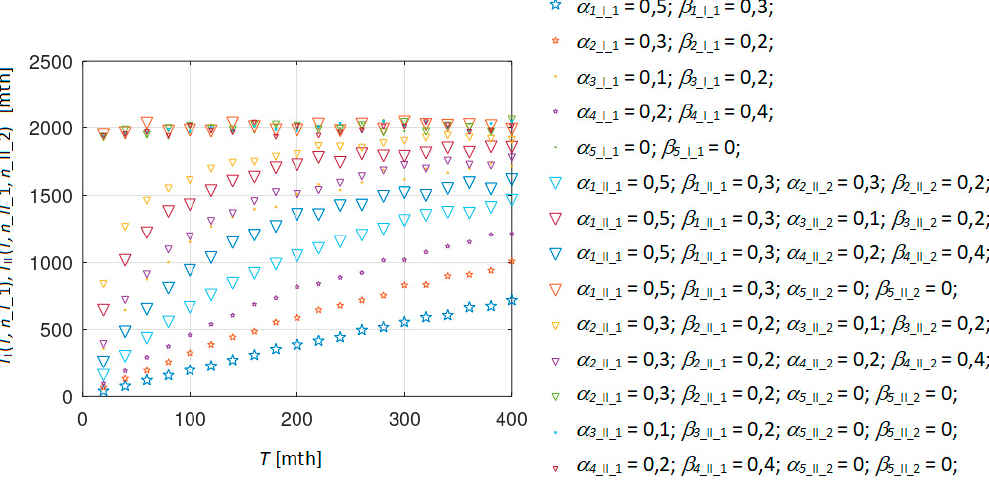
Figure 7. The expected lifetime of the sealing for the inspection interval T if the one-stage and various combinations of the two-stage policy are applied.